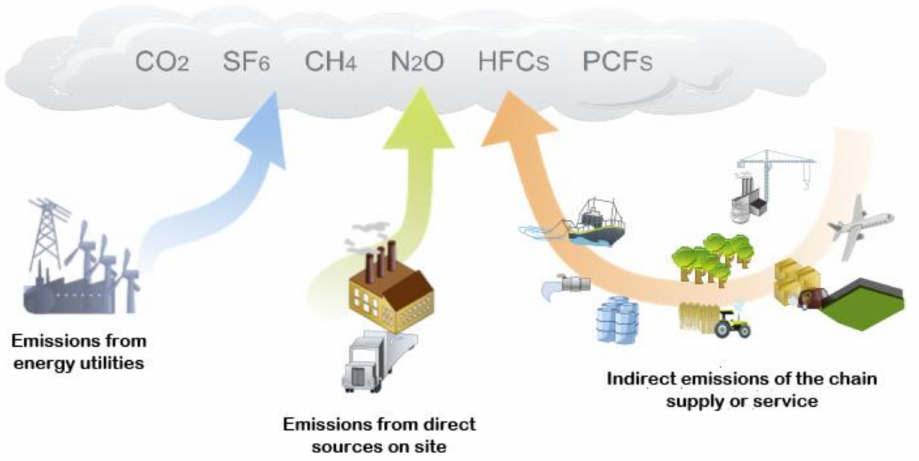
Figure 1. Sources of main greenhouse gas emission [1]; originally published under Creative Commons Attribution 3.0 Unported (CC BY 3.0)